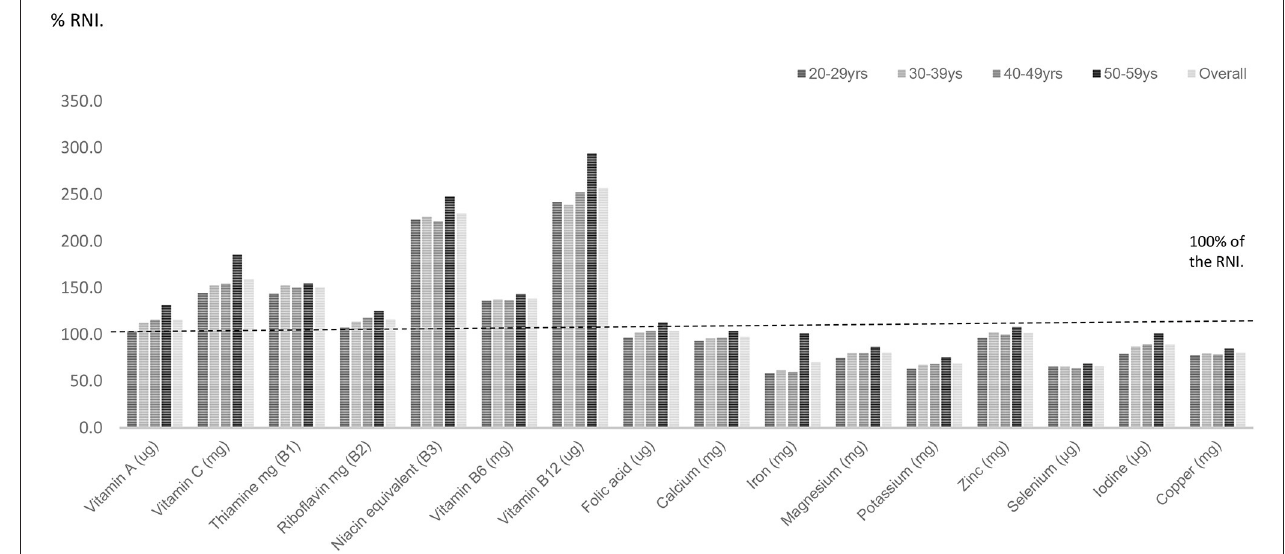
FIGURE 2 | Percentage RNI for UK females across mid-life.